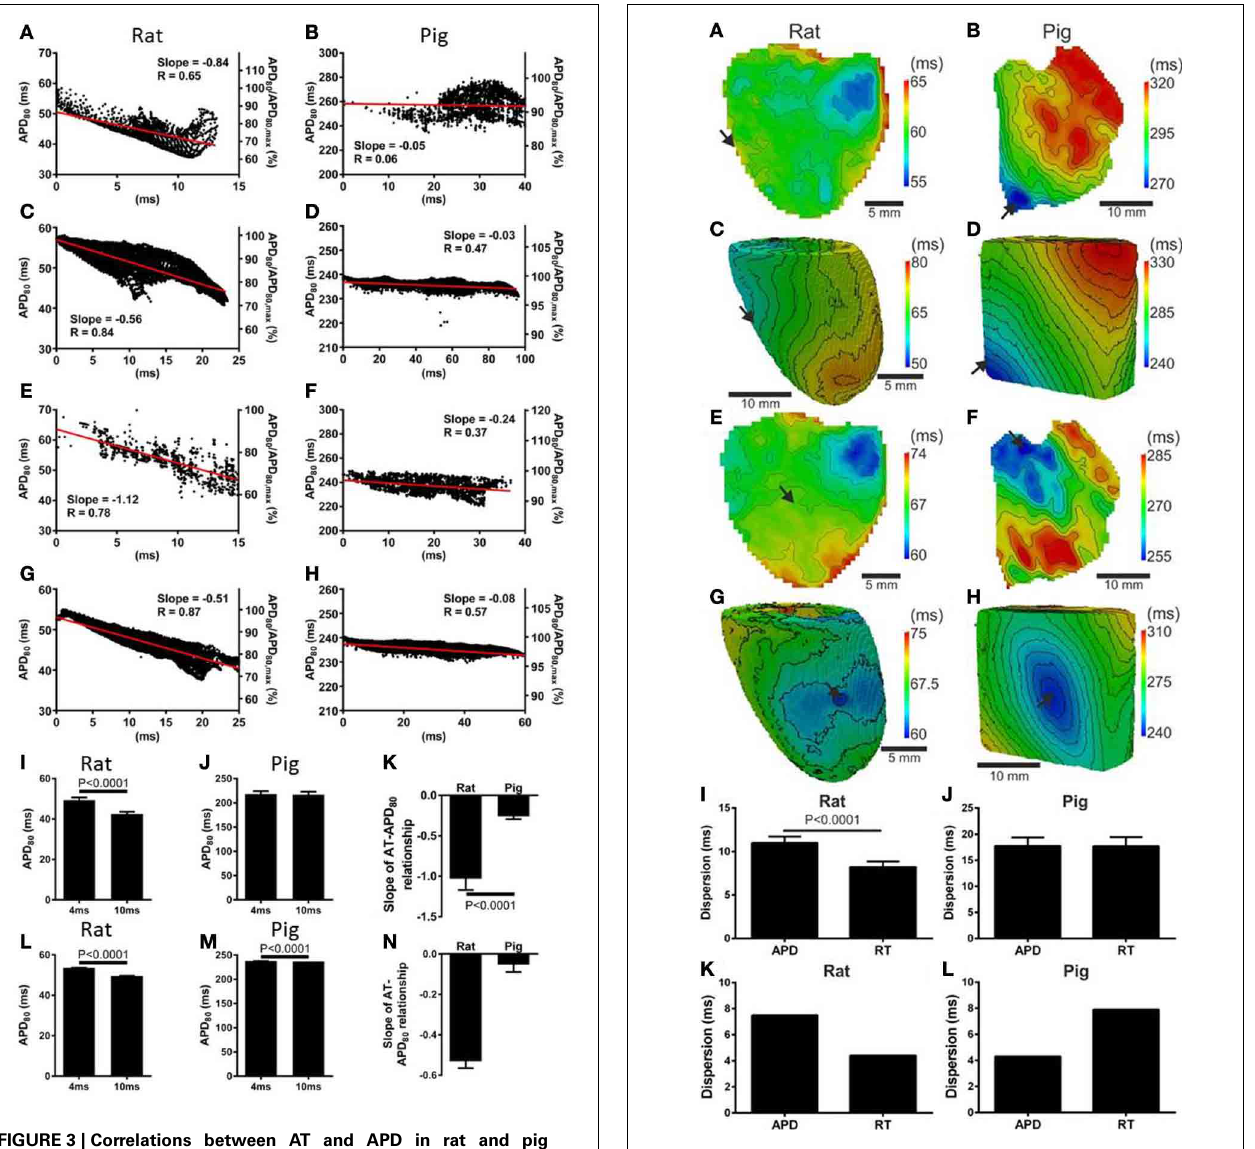
FIGURE 4 | Left ventricular dispersion of RT in rat and pig myocardium. RT maps corresponding to maps shown in Figure 1 for rat (A) and pig (B) experiments and rat (C) and pig (D) simulations. Similarly, RT maps for an alternative pacing location, as in Figure 2 , are shown for rat (E) and pig (F) and repeated for rat (G) and pig (H) simulations. Stimulation sites are indicated by arrows. Mean ± SD dispersion of APD and RT pooled from each pacing location are compared across all experiments in rat (I) and pig (J) . All mean differences from experiments were compared using paired t -tests. Significant differences are indicated if P < 0 . 05. Similarly to experiments, dispersion of APD and RT were compared for rat (K) and pig (L) simulations shown in Figure 2 . to RT dispersion supported experimental findings showing reduced RT dispersion in rat (41.3%, Figure 4K ) but a rel- ative and robust gain of RT dispersion in pig (83.7%, Figure 4L